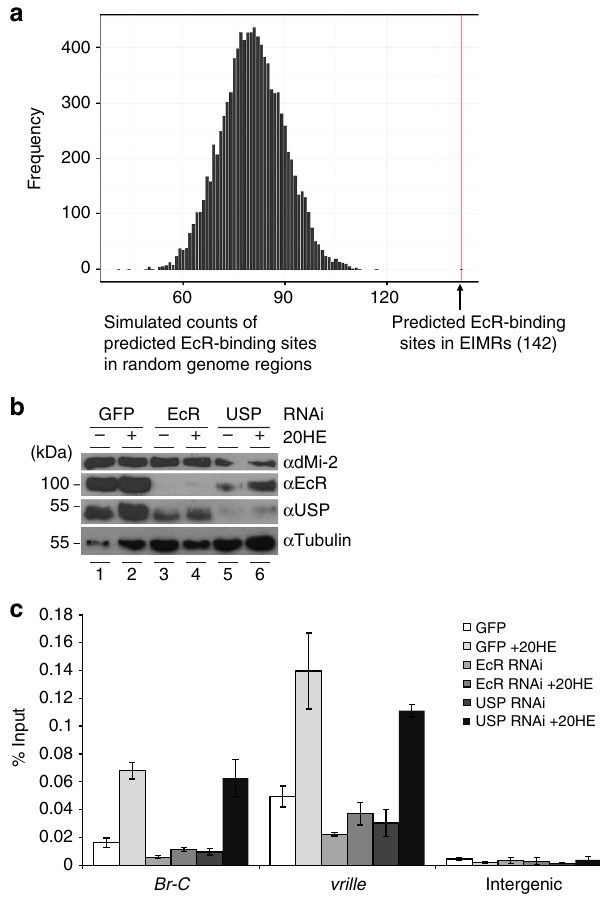
Figure 3 | EcR but not USP is essential for recruitment of dMi-2 to ecdysone-activated genes. ( a ) Enrichment of predicted EcR–USP-binding sites in EIMRs. The histogram shows the distribution (sampled from 10,000 runs) of putative EcR–USP site number within the same number of randomly selected genomic regions with the same sizes as the experimentally determined EIMRs. The red line indicates the number of computationally identified EcR–USP-binding motifs within EIMRs (142; P o 10-8). The P -value for the observed number of binding motifs was estimated from the normal distribution that can be approximated based on the displayed simulated distribution, that is, using mean and s.d. estimates from the simulated sample. ( b ) Western blot analysis of protein extracts of S2 cells treated with dsRNA directed against GFP (control), EcR or USP. Cells were either left untreated ( (cid:2) 20HE) or were treated with ecdysone ( þ 20HE). Antibodies used are shown on the right, molecular masses on the left. Tubulin served as a loading control. ( c ) dMi-2 binding to Br- C and vrille following EcR and USP depletion analysed by ChIP-qPCR. Chromatin was prepared from S2 cells that were first treated with dsRNA against GFP (control), EcR or USP and then either left untreated or were exposed to 1 m M ecdysone for 6h as indicated. ChIP-qPCR was performed with dMi-2 antibody. Error bars denote s.d. of technical triplicates. Experiments were performed as biological triplicates. One representative example is shown.